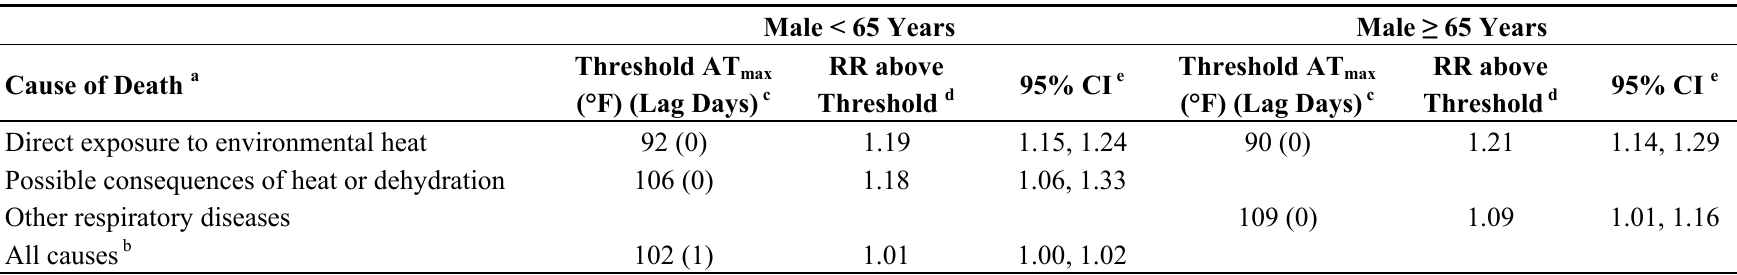
other causes potentially related to high temperatures during the months May–October for years